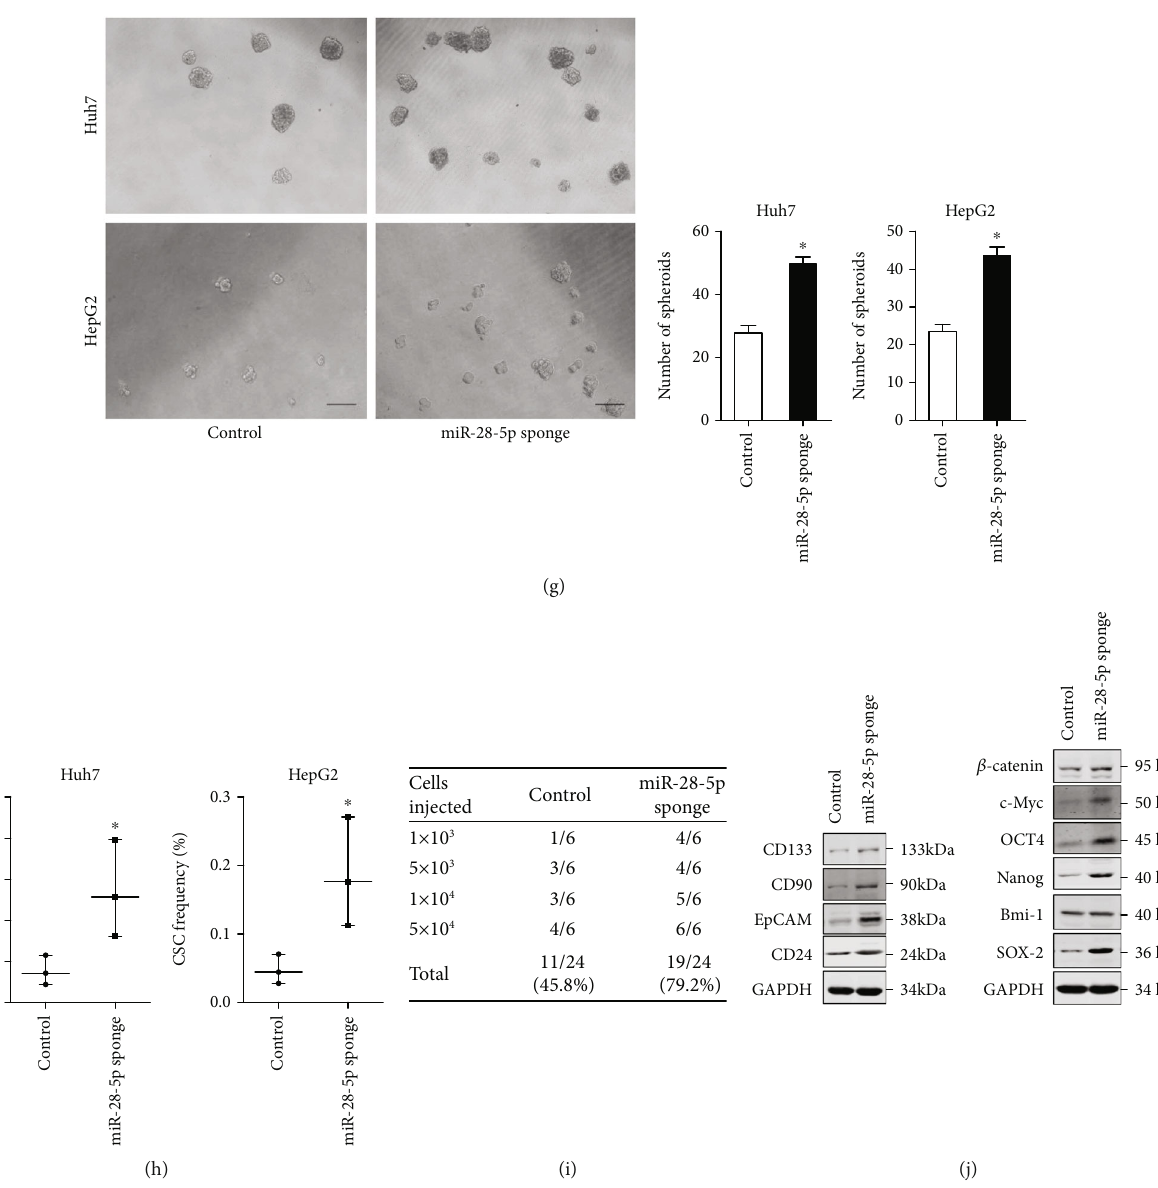
Figure 2: miR-28-5p interference derives liver CSC expansion. (a) Huh7 and HepG2 cells were infected with miR-28-5p sponge virus and control virus. The miR-28-5p interference e ff ect was determined by RT-PCR assay ( n = 3 ). (b) The mRNA expression of liver CSC markers in the miR-28-5p sponge and control HCC cells was checked by RT-PCR assay ( n = 3 ). (c) The protein expression of liver CSC markers in the miR-28-5p sponge and control HCC cells was checked by western blot assay. GAPDH acted as a loading control. (d) The mRNA expression of stemness-associated genes in the miR-28-5p sponge and control HCC cells was checked by RT-PCR assay ( n = 3 ). (e) The protein expression of stemness-associated genes in the miR-28-5p sponge and control HCC cells was checked by western blot assay. GAPDH acted as a loading control. (f) The EpCAM-positive cells in the miR-28-5p sponge and control HCC cells was determined by fl ow cytometry ( n = 3 ). (g) The self-renewal ability of the miR-28-5p sponge and control HCC cells was compared by spheroid formation assay ( n = 3 ). (h) In vitro limiting dilution assay of the miR-28-5p sponge and control HCC cells. The results are shown as a natural logarithm of the proportion of CSCs ( n = 6 ). (i) The tumorigenicity of liver CSCs in the Huh7 miR-28-5p sponge and its control cells was compared by in vivo limiting dilution assay. Tumors were observed over 2 months; n = 6 for each group. (j) The protein expression of liver CSC markers and stemness-associated genes in above xenograft tumors was checked by western blot assay. GAPDH acted as a loading control. Data are represented as mean ± s : d : ; ∗ P < 0 : 05 ; two-tailed Student ’ s t